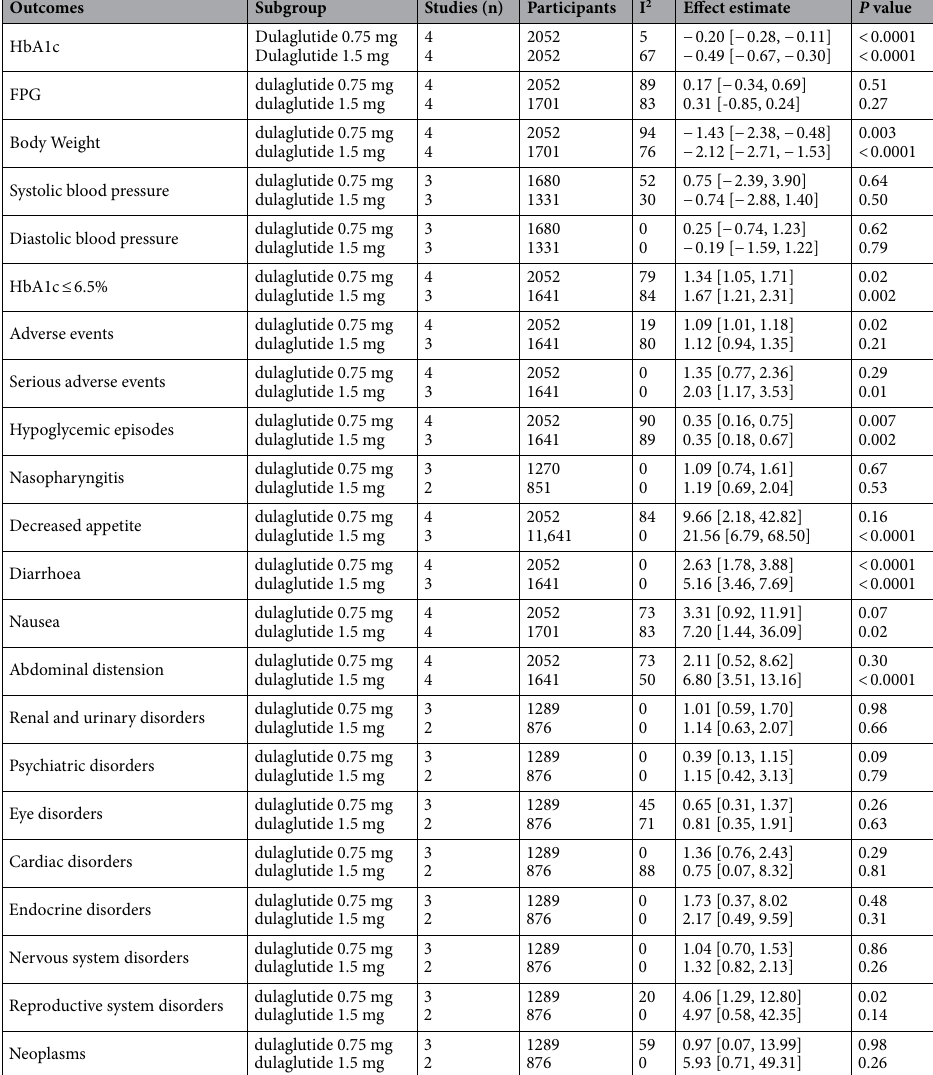
Table 2. The results of efficacy and safety in